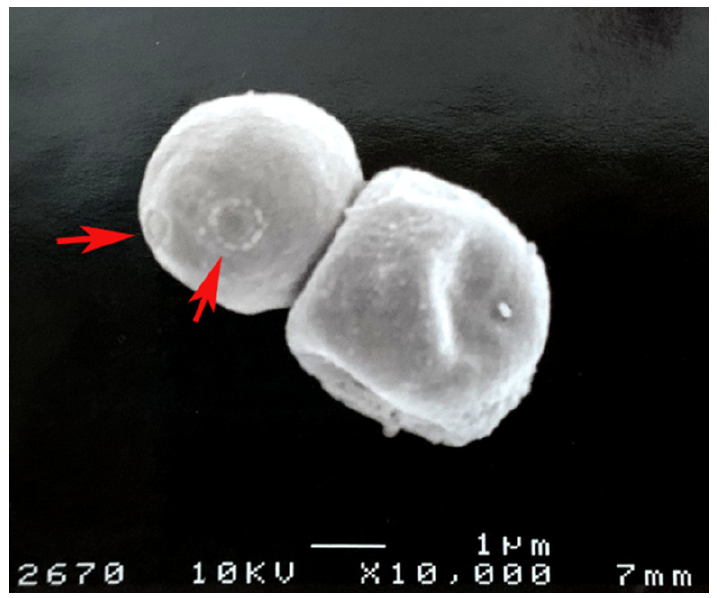
Figure 2. Cryptococcus neoformans melanin “ghosts” obtained from lungs of infected mice as described in [20]. The red arrows show bud scars on the melanin.